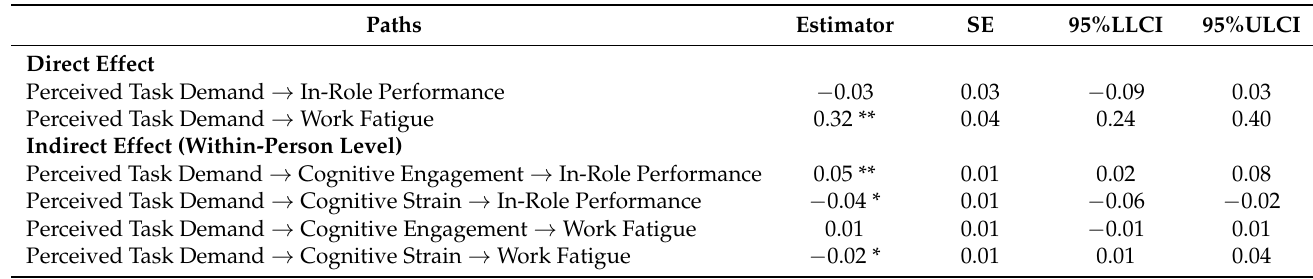
Table 4. Results of Monte Carlo bootstrapping test.